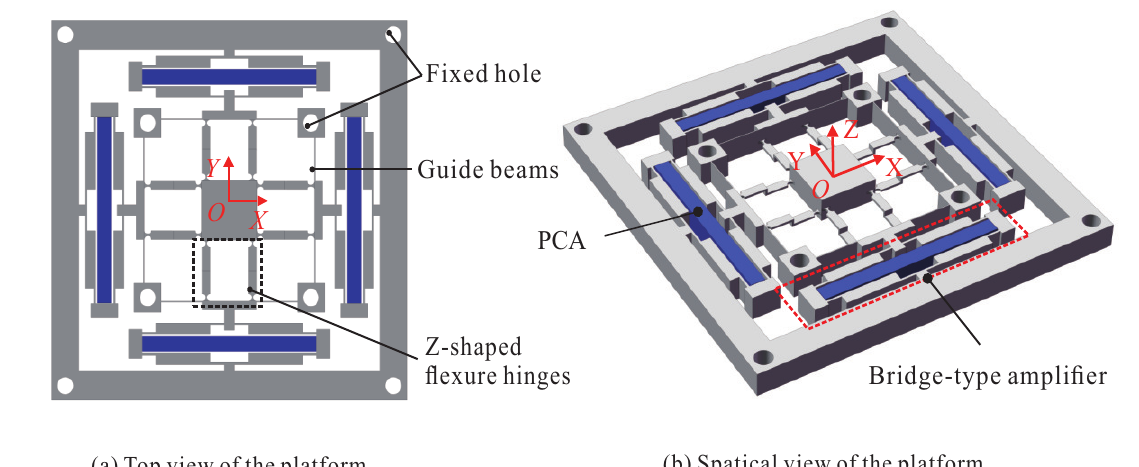
Figure 3. Structure design of the